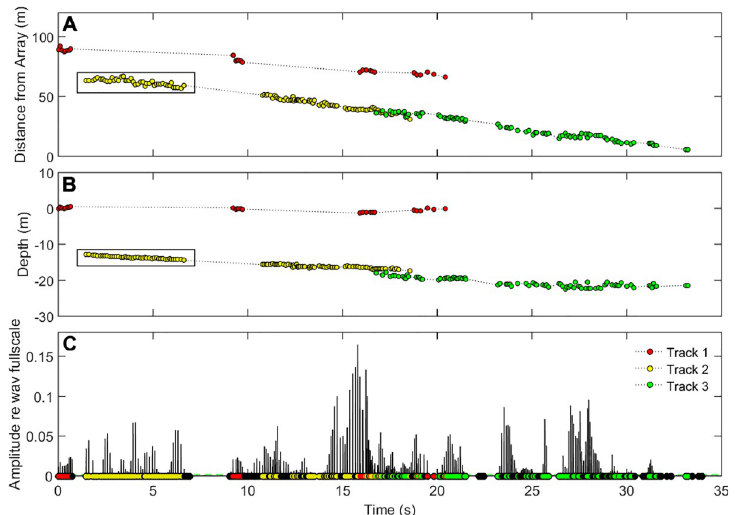
Fig 4. Echolocation localization tracklines assigned for at least three individual belugas. (A) localized distance from the array, (B) localized depth, and (C) Hilbert transform of the received amplitude for channel 10 recordings used for click detections. The black box indicates the click sequence used for Fig 7. Red circles are track 1, yellow circles track 2, and green circles track 3. Spatial information separates the individual shown in red from the individuals in yellow and green. Patterns in ICI, RL, and localized distance and depth allow for separation of the individuals assigned in yellow and green.